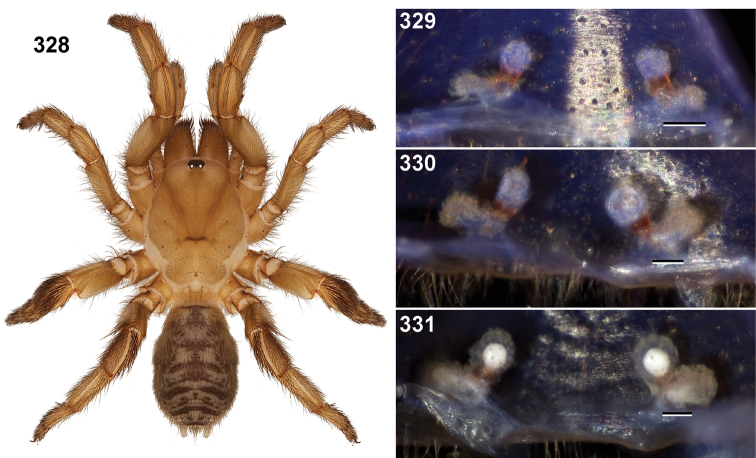
Aptostichus cajalco sp. n. female specimens from Riverside County. 328 habitus, female paratype (MY3778) [806382] 329–331 cleared spermathecae; scale bars = 0.1mm 329 MY3778 [806385] 330 AP668 [806386] 331 AP669 [806389].